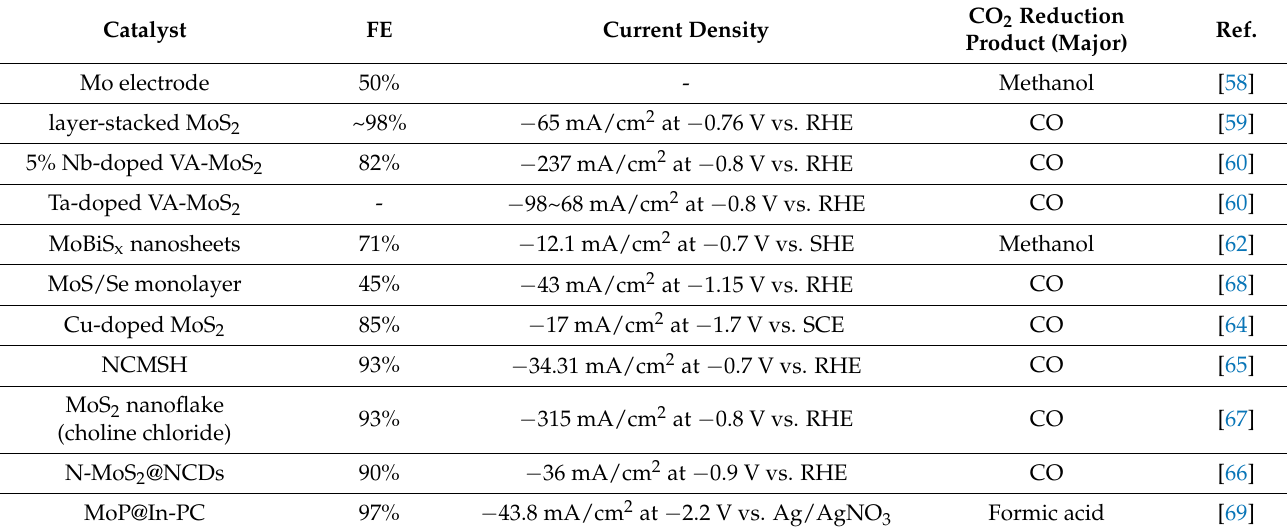
Table 1. Compared CO 2 reduction catalytic efficiencies of Mo-based